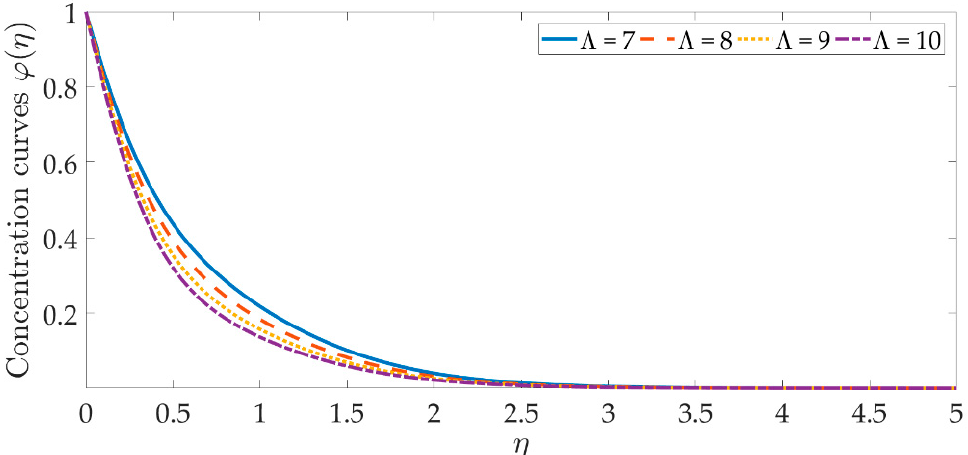
L Figure 16. Concentration curves against the multiple values of Λ L